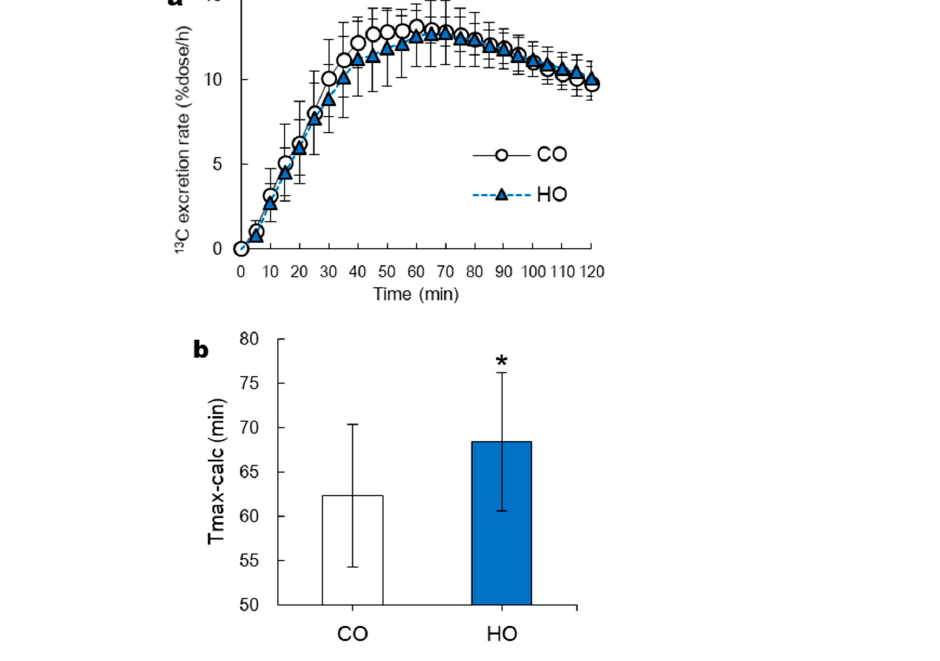
Figure 3. Time course of 13 C excretion responses ( a ) and Tmax-calc of 13 C excretion rate ( b ) following consumption of pumpkin soup containing 9.2 g of either intact corn oil (CO) or heated corn oil (HO) ( b ) in Experiment 1. Mean ± SD. * p < 0.05 (CO vs. HO). In Experiment 2, immediately before and 15 min after consumption of pumpkin soup, absolute CSA of the gastric antrum did not differ between the trials (immediately before consumption: 2.4 ± 1.2 cm 2 in CO, 2.1 ± 1.1 cm 2 in HO, and 2.5 ± 1.2 cm 2 in 2,4-DD trial; 15 min after consumption: 9.0 ± 3.2 cm 2 in CO, 8.4 ± 4.1 cm 2 in HO, and 9.4 ± 3.1 cm 2 in